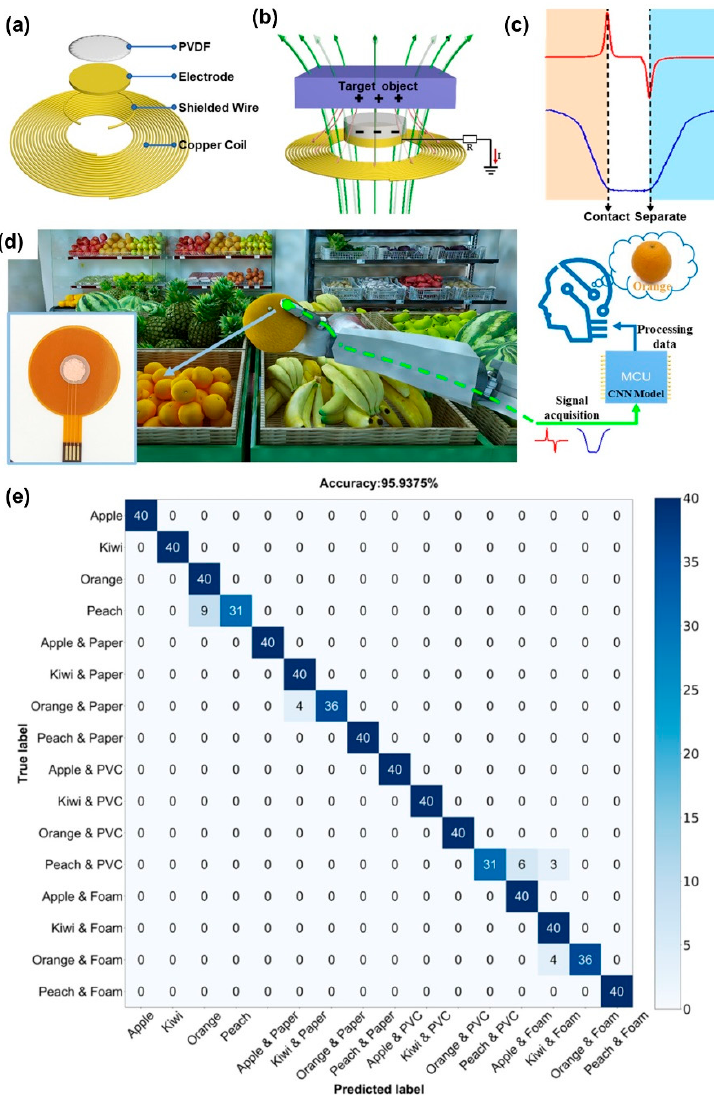
Figure 12. Schematic illustration of the dual-mode tactile sensor. ( a ) Design of the dual-mode tactile sensor. ( b ) Working mechanism of the dual-mode tactile sensor. ( c ) Typical signals from the dual-mode tactile sensor when touching an object. ( d ) Concept of object recognition by a robotic gripper equipped with the dual-mode tactile sensor. ( e ) The confusion matrix derived from the CNN model with the database of dual-mode signals. Reprinted/adapted with permission from Ref. [97]. Copyright 2022, Elsevier.